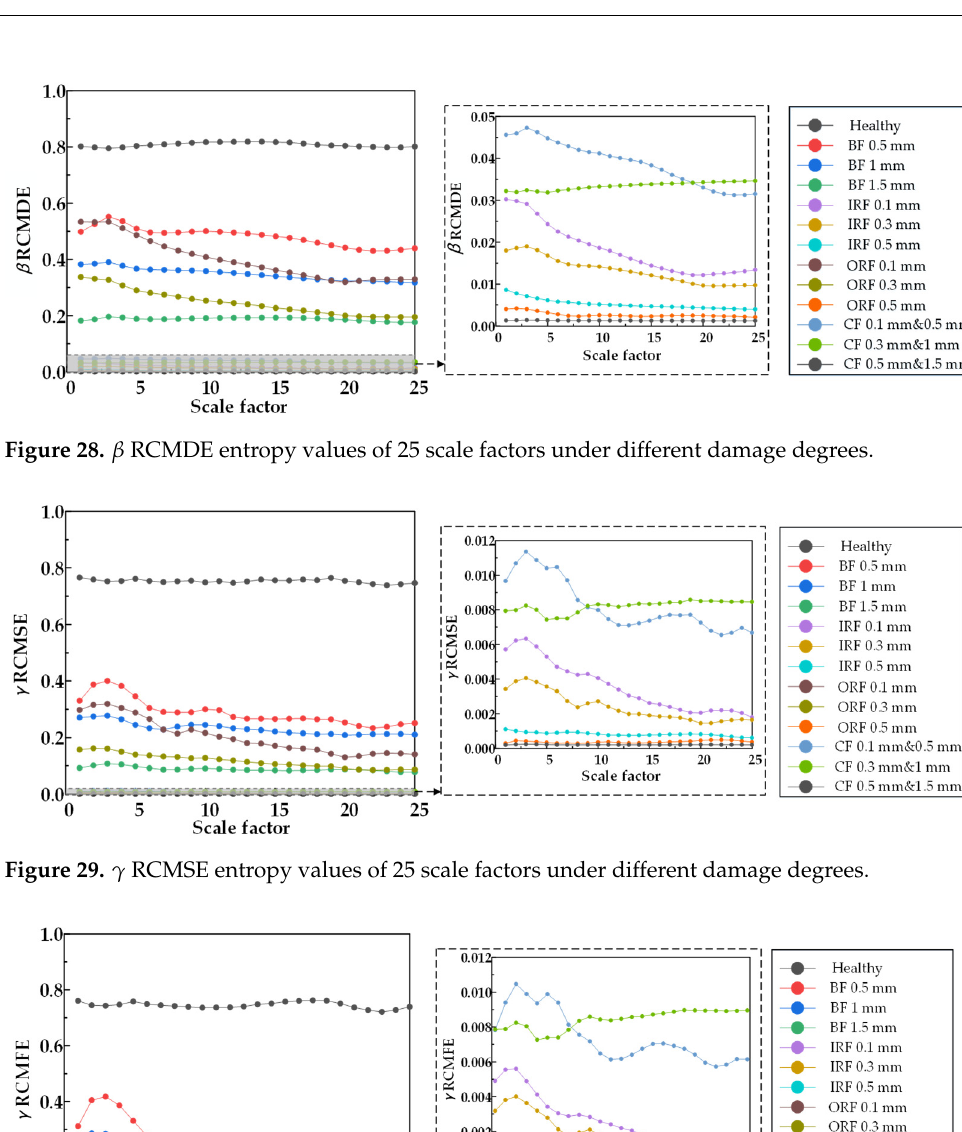
24 of 30 Figure 25. α RCMDE entropy values of 25 scale factors under different damage degrees. Figure 26. β RCMSE entropy values of 25 scale factors under different damage degrees.